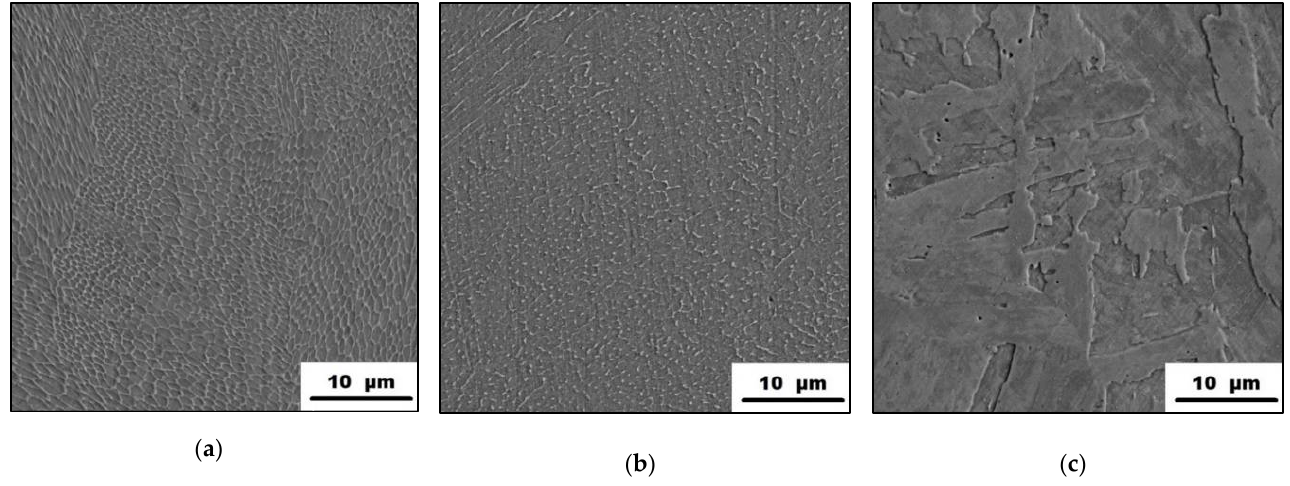
Figure 6. Microstructure of the 1.2709 maraging steel in different states showing: ( a ) as-printed; ( b ) as-printed, 500 °C/2 h; ( c ) as-printed, 900 °C/2 h materials (SEM). ( b ) as-printed, 500 ◦ C/2 h; ( c ) as-printed, 900 ◦ C/2 h materials